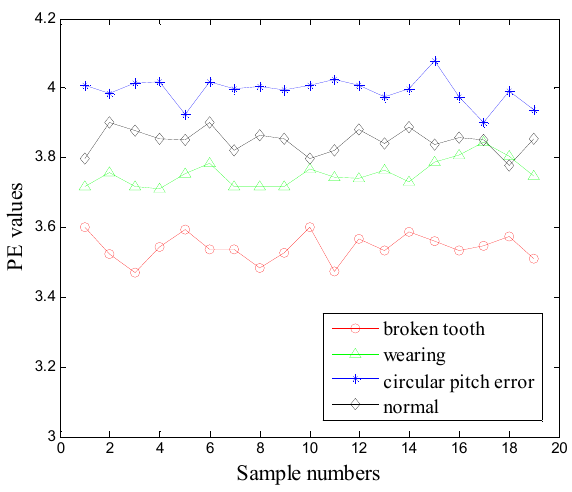
Figure 35. The permutation entropies of the proposed approach.